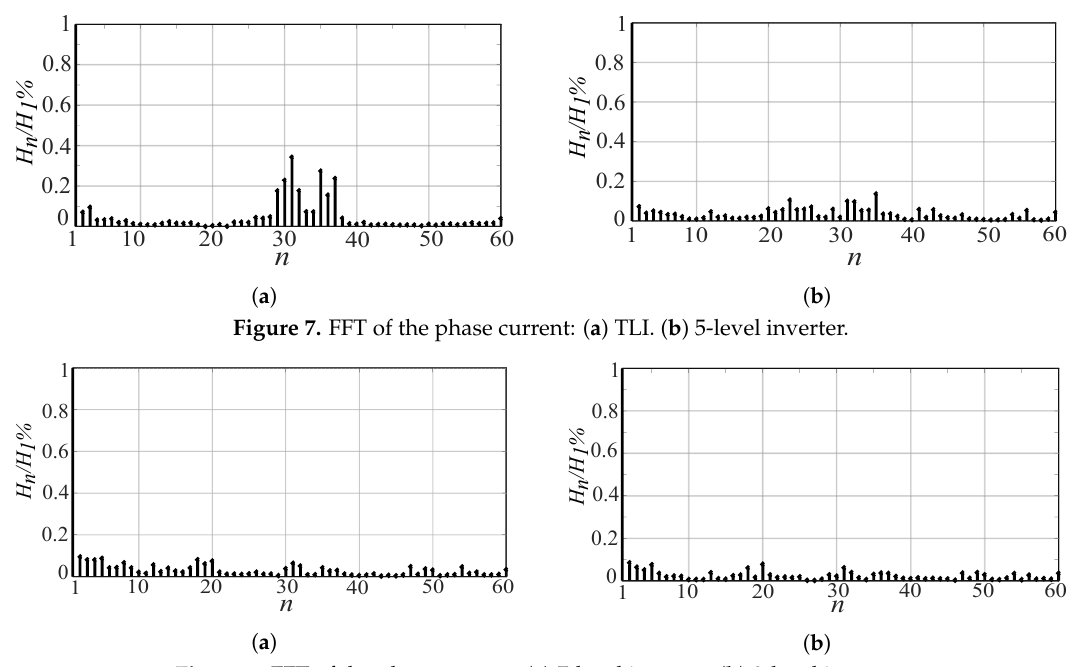
Figure 8. FFT of the phase current: ( a ) 7-level inverter. ( b ) 9-level inverter.